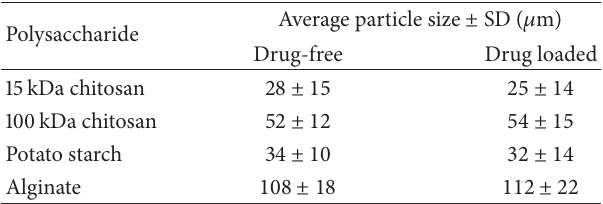
Table 1: Average particle size of polysaccharide-based micro-